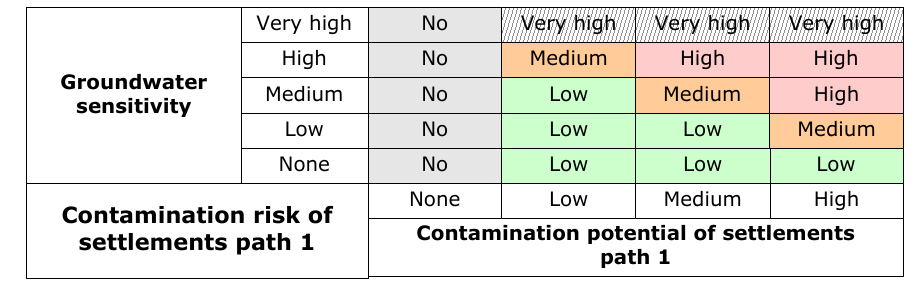
Figure 12. Aggregation of sensitivity of groundwater and the contamination potential of settlements to contamination